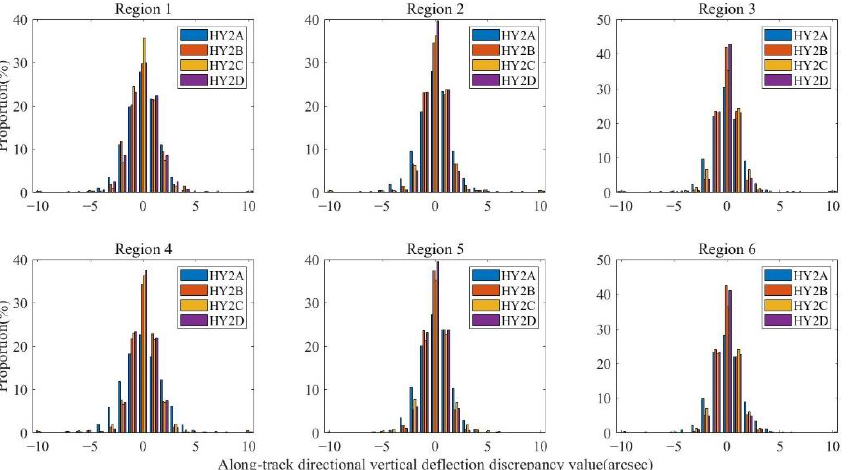
Figure 11. Distributional proportion of discrepancies between HY-2 along-track vertical deflections and XGM2019 model (unit: arcsec): Region 1, North Pacific; Region 2, South Pacific; Region 3, Mid-Pacific; Region 4, Indian Ocean; Region 5, North Atlantic; Region 6, South Atlantic.